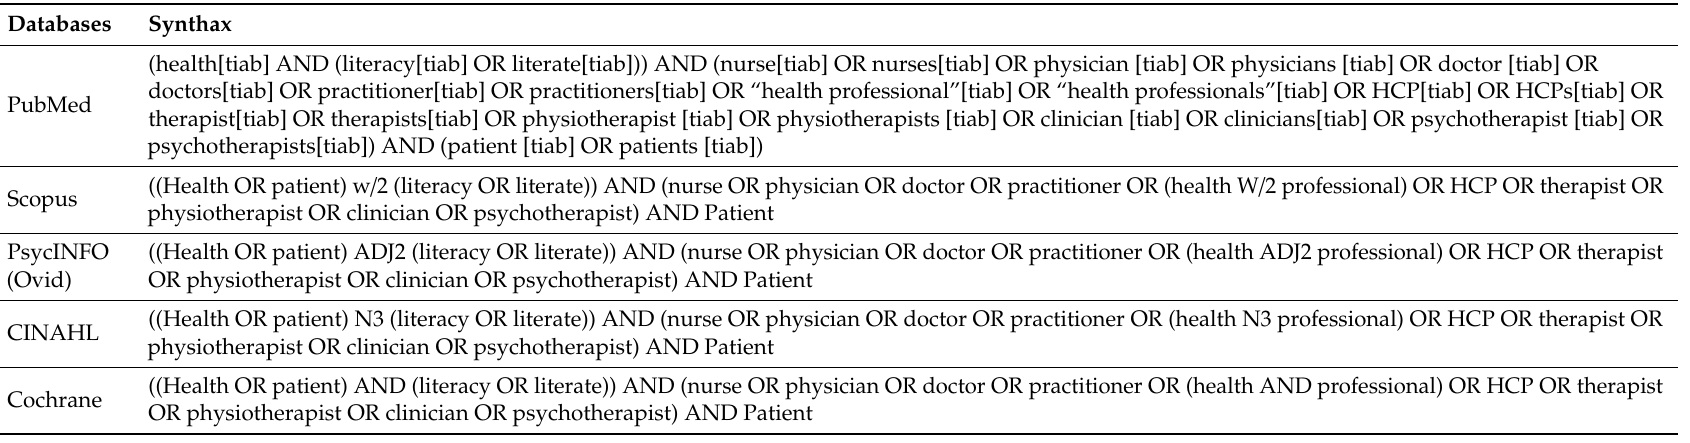
Table A2. Detailed Search